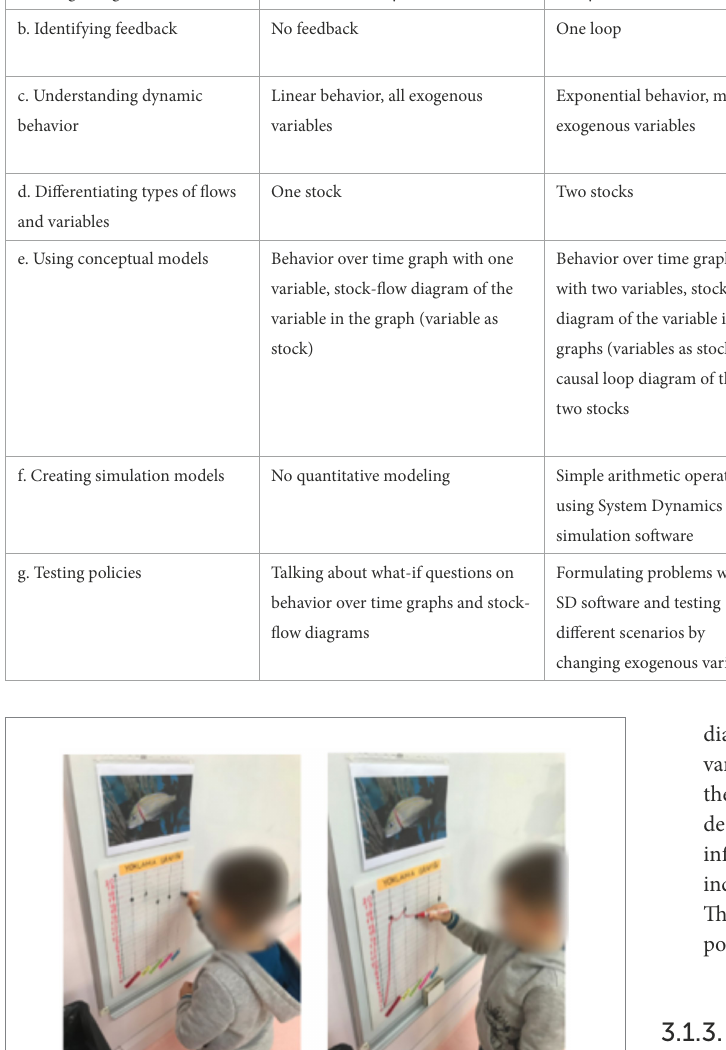
FIGURE 2 A kindergarten student marking a dot on an attendance graph then connecting the dots, creating a BOTG.